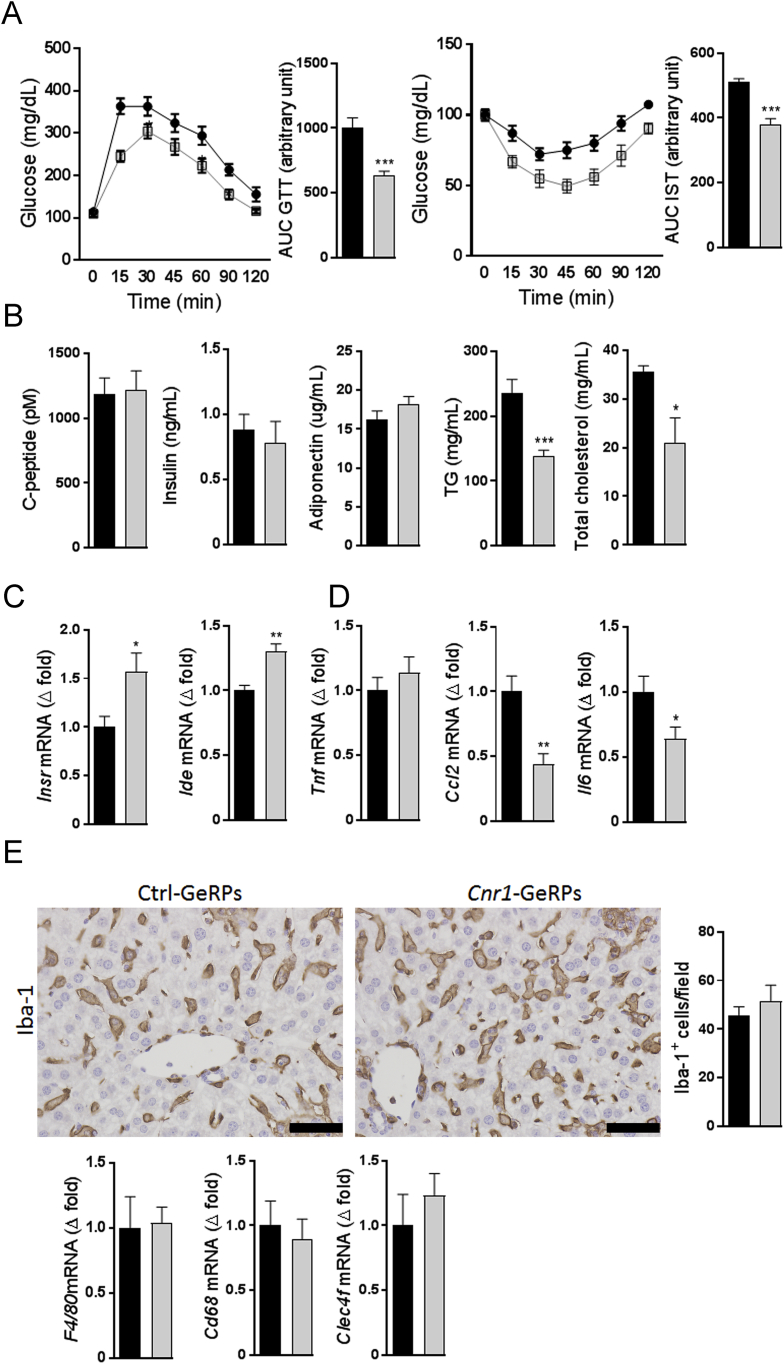
Cnr1 knock-down in Kupffer cells of DIO mice improves glucose tolerance, insulin sensitivity and reduces hepatic inflammation. A Glucose tolerance (GTT) and insulin sensitivity test (IST) from DIO mice treated with control (black columns, n = 10) or Cnr1-GeRPs (light grey columns, n = 10). Points and bars are means ± SEM from 2 independent experiments. Areas under the curve (AUC) from each experiment were used for statistical analyses. B Plasma concentrations of c-peptide, insulin, adiponectin triglycerides, and total cholesterol. C Whole liver gene expression of insulin receptor (Insr) and insulin-degrading enzyme (Ide). D Whole liver gene expression of the pro-inflammatory cytokines Tnf, Ccl2 and Il-6. E Hepatic macrophage histology as assessed by Iba-1 immuno-staining (scale bars: 50 μm) and whole liver gene expression of macrophage markers F4/80, Cd68, and Clec4f. Columns and bars represent means ± SEM. Significant differences from values in control-GeRPs treated obese mice *P < 0.05, **P < 0.01, ***P < 0.001.